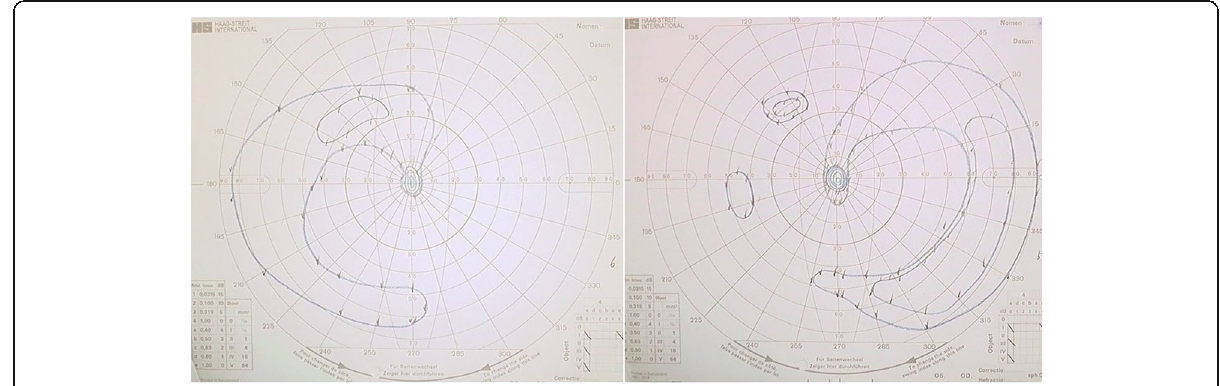
Fig. 4 Although visual field revealed concentric contraction in both eyes, central visual field of the both eyes are